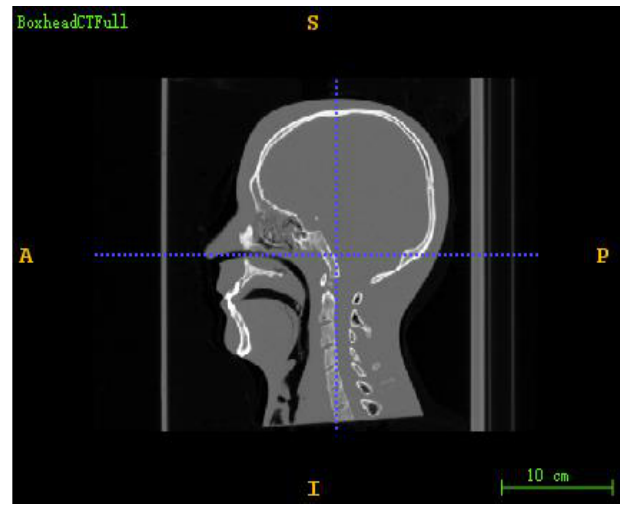
Figure 1. Three dimensional CT image of the brain model.